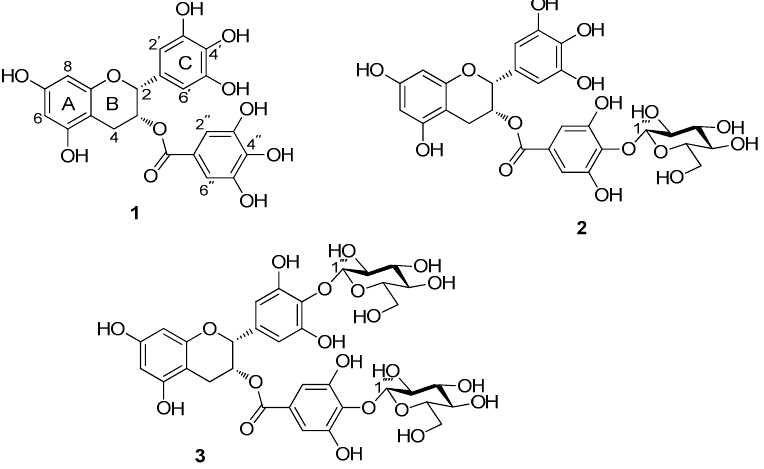
Figure 1. Structures of EGCG ( 1 ), EGCG-G1 ( 2 ), and EGCG-G2 ( 3 ).